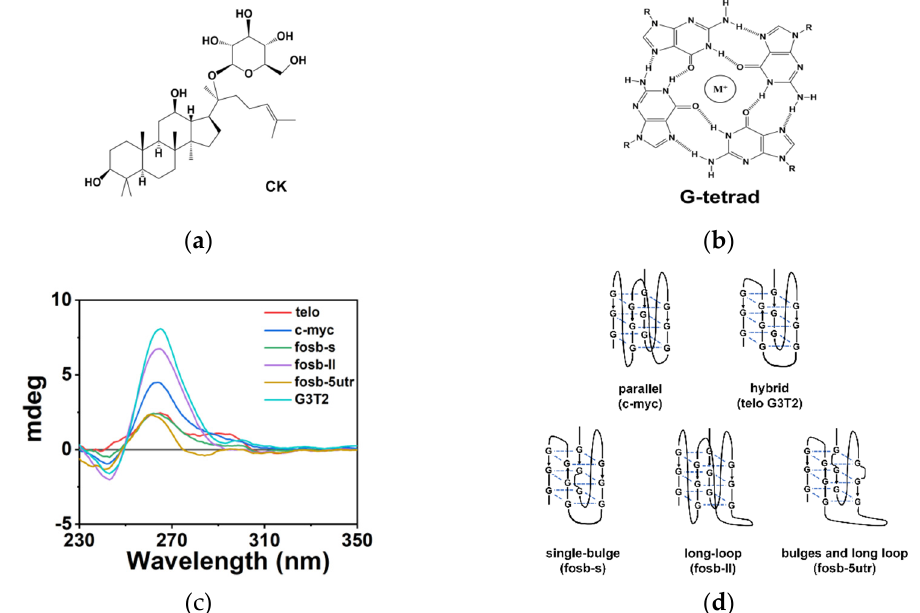
Figure 1. ( a ) The molecular formula of CK. ( b ) The illustration of G-tetrad. ( c ) The CD spectra of six G4 sequences in a buffer containing 40 mM Tris-HCl (pH 7.6), 8 mM MgCl 2 , and 60 mM KCl. ( d ) The schematic of expected structures of G4s used in this work.